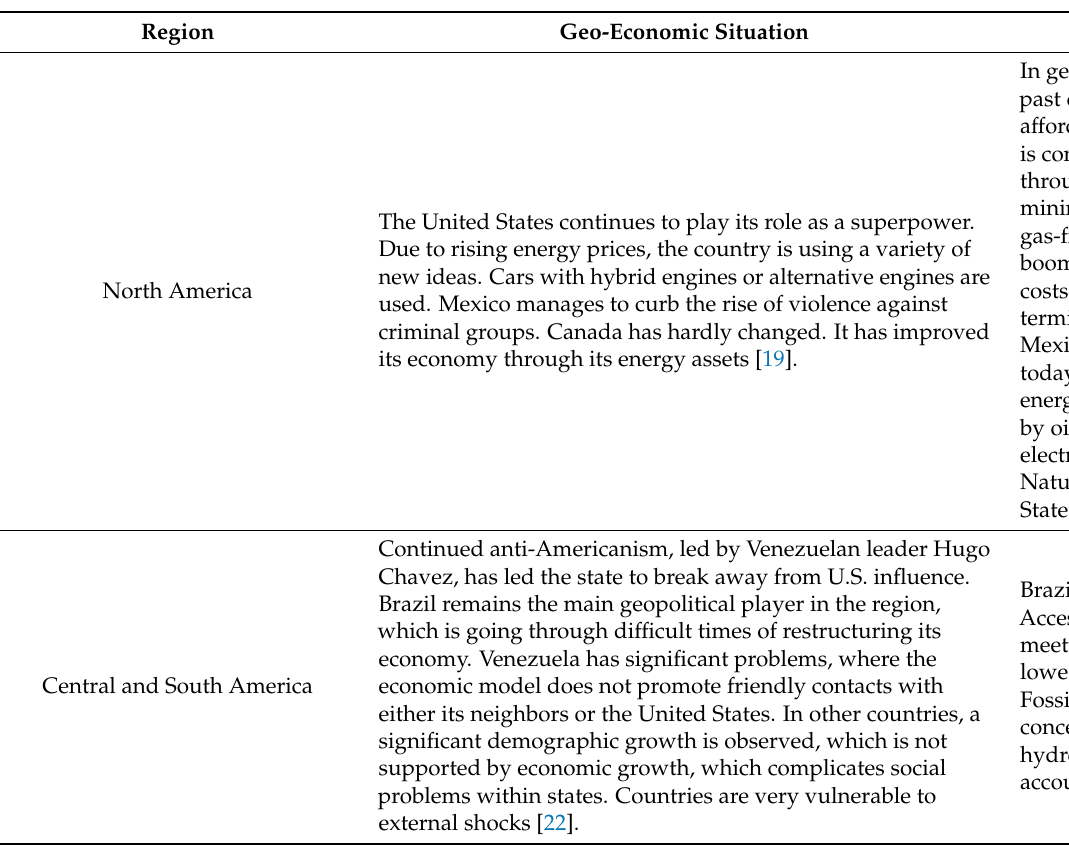
Table A1. The correspondence of the geo-economic and energy situations in the